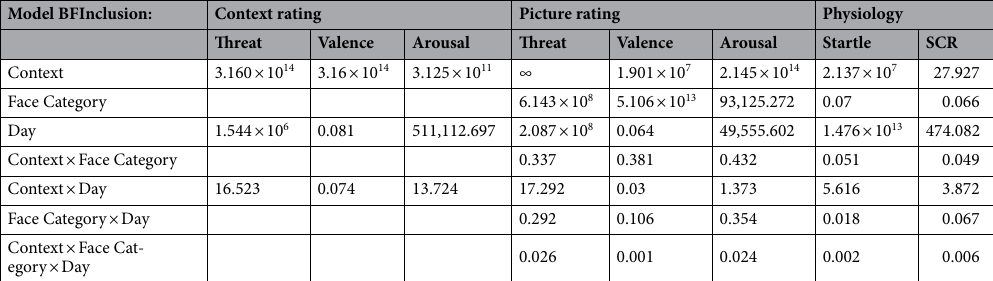
Table 1. Bayes factors (BF incl ) of the selected models compared to all models without this factors for the different dependent